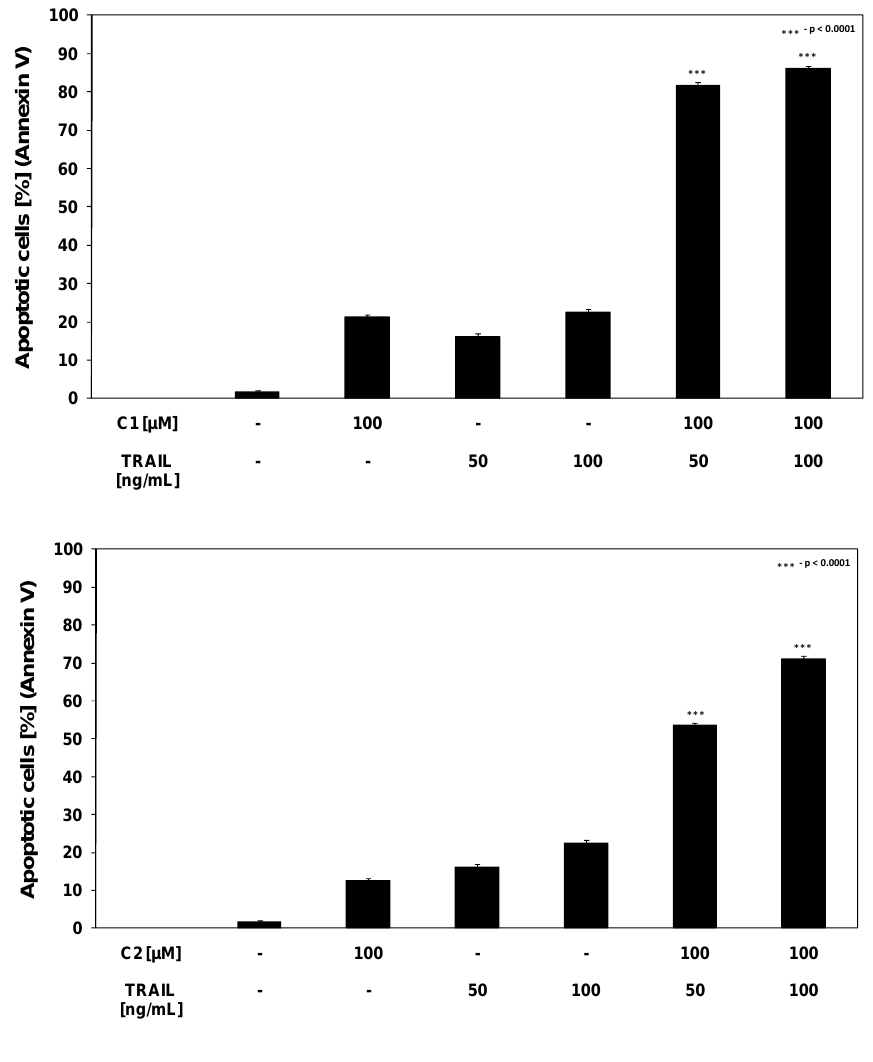
Figure 6. TRAIL induced apoptosis in combination with chalcones and